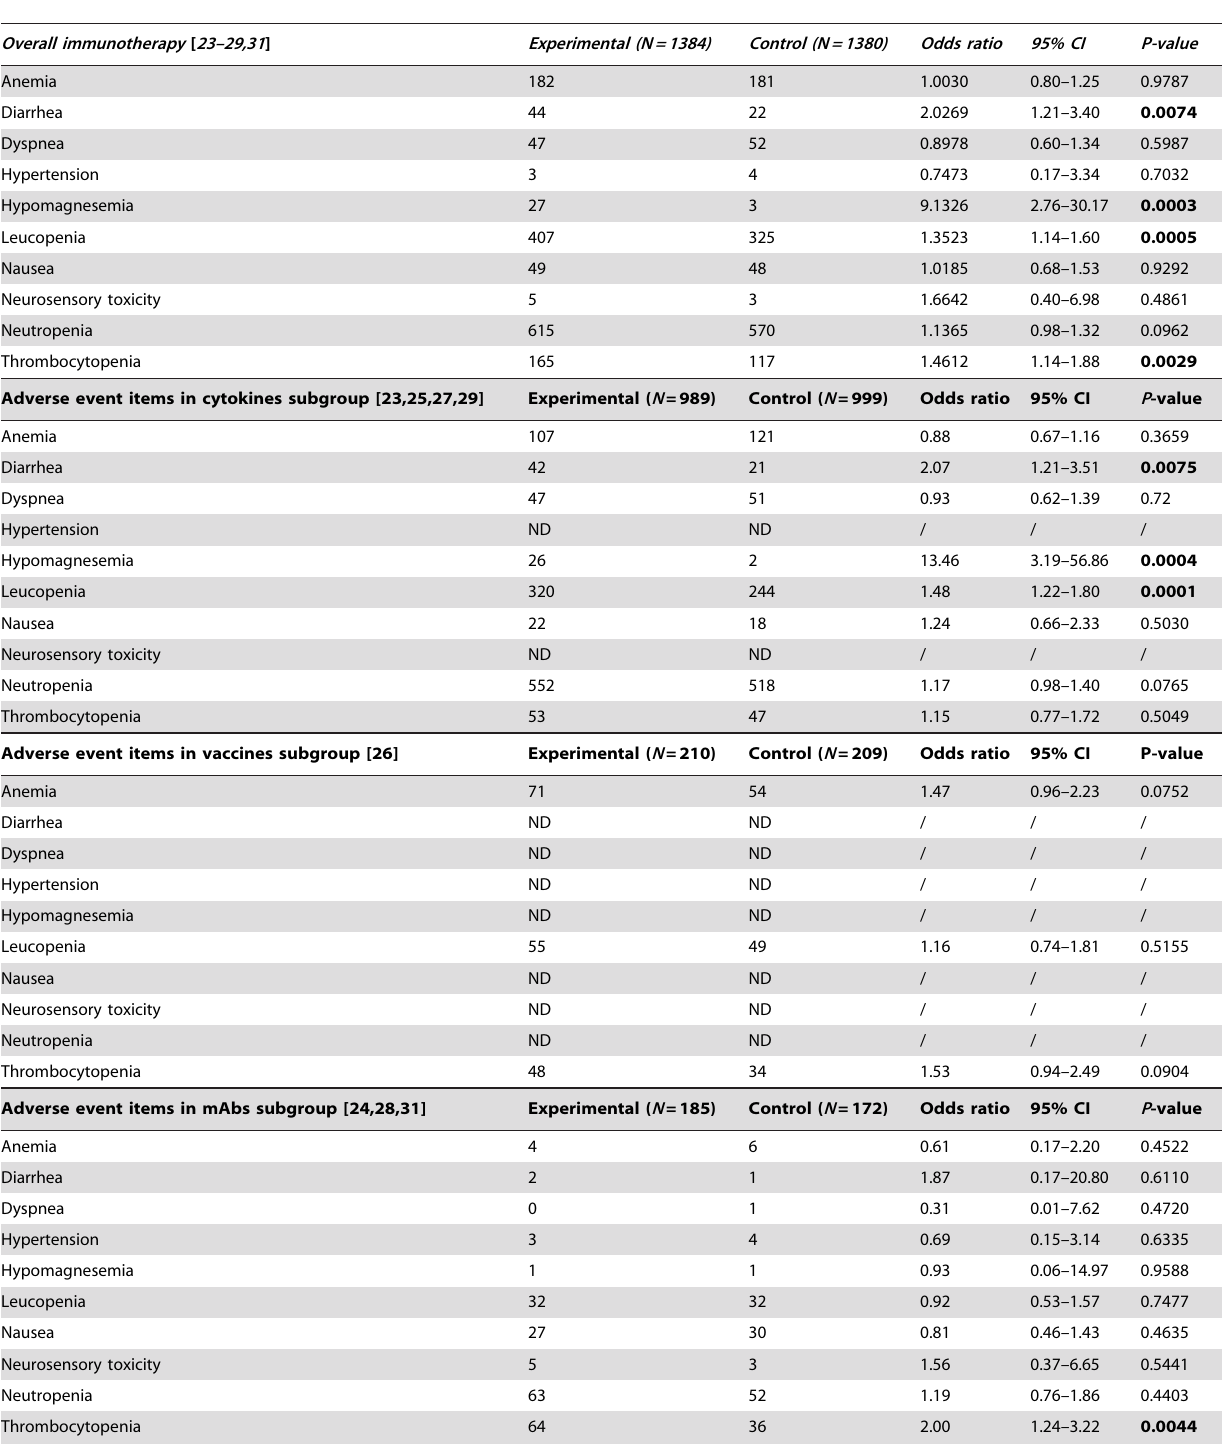
Table 6. Adverse events (grade $ 3) in overall immunotherapy and subgroups of advanced NSCLC